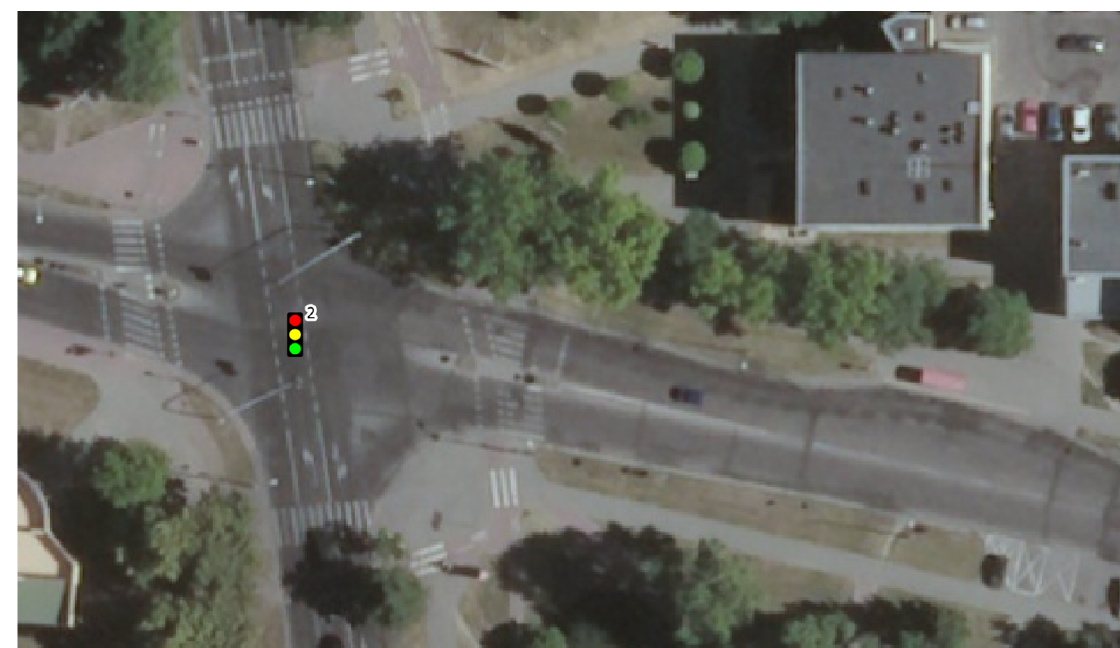
Figure 4. Traffic organization at intersection No. 2. (Background map Head Office of Geodesy and Cartography). A signaling program with a cycle duration of 90 s was in operation during measure- ments at the intersection. The green signal duration was 30 s. At intersection No. 3, measurements were made at the western approach. There are two 3 m wide lanes for straight-ahead driving. Besides, there is a left-turn and right-turn lane. The traffic organization at intersection No. 3 is shown in Figure 5.